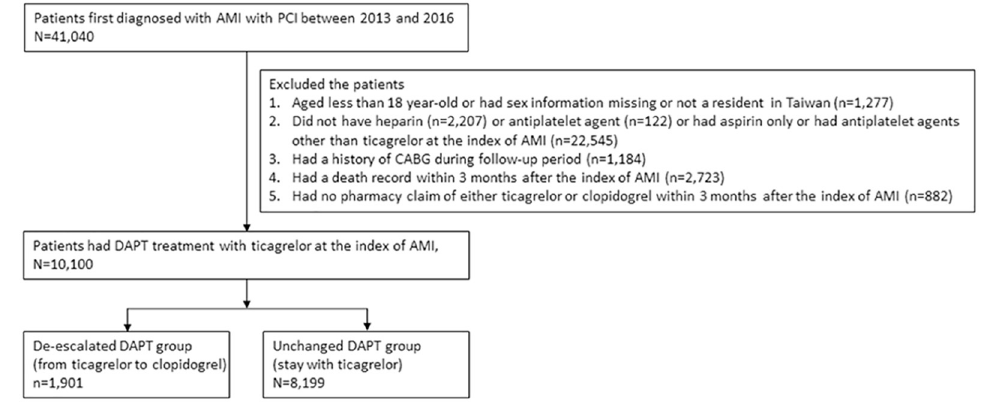
Fig 1. Patient selection process. Abbreviation: AMI = acute myocardial infarction; CABG = coronary artery bypass surgery; PCI = percutaneous coronary intervention.